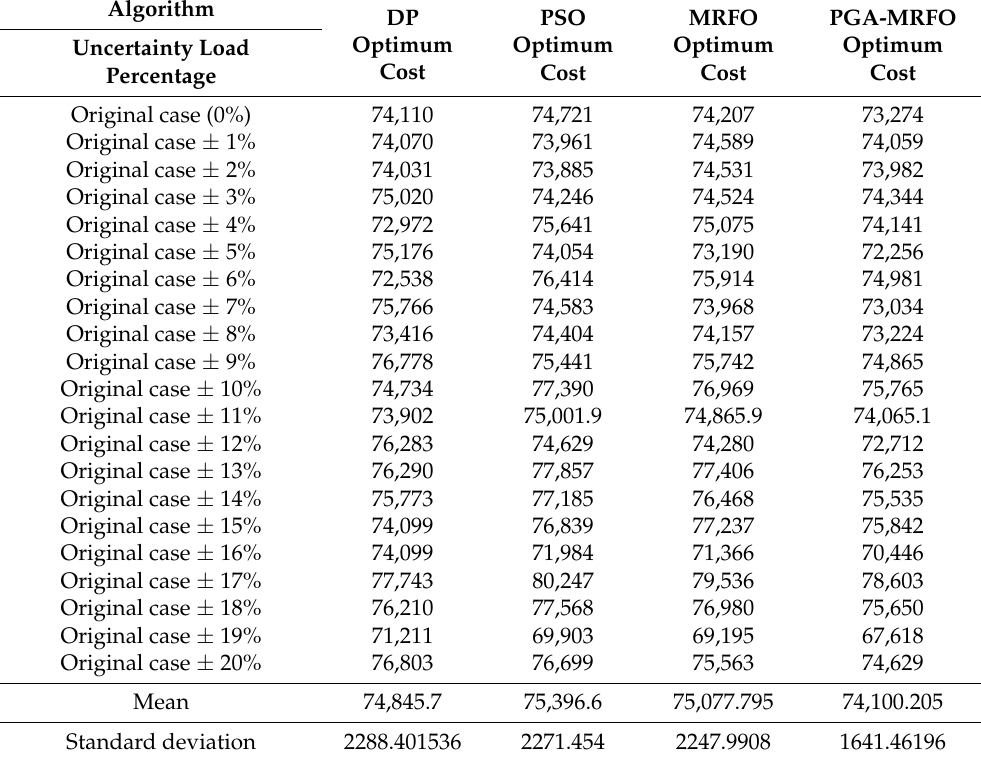
Table 7. Algorithms’ results due to load uncertainty.